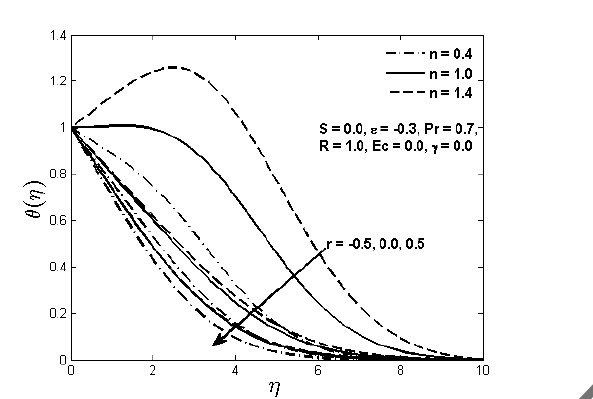
Figure 9. Temperature profiles for various values of r and n when (cid:101) < 0.